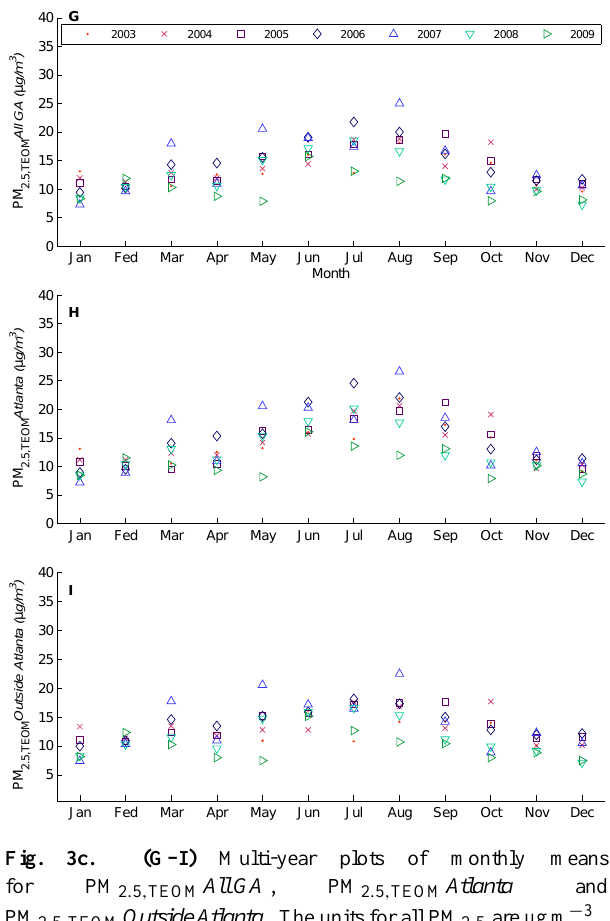
Fig. 3c. (G–I) Multi-year plots of monthly means for PM 2 . 5 , TEOM AllGA , PM 2 . 5 , TEOM Atlanta and PM 2 . 5 , TEOM OutsideAtlanta . The units for all PM 2 . 5 are µgm − 3 .